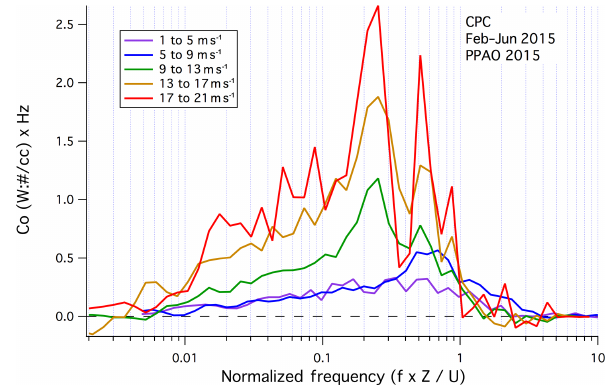
Figure 2. Averaged CPC frequency-weighted (net) aerosol number cospectra in wind speed bins for the southwest (open water) wind